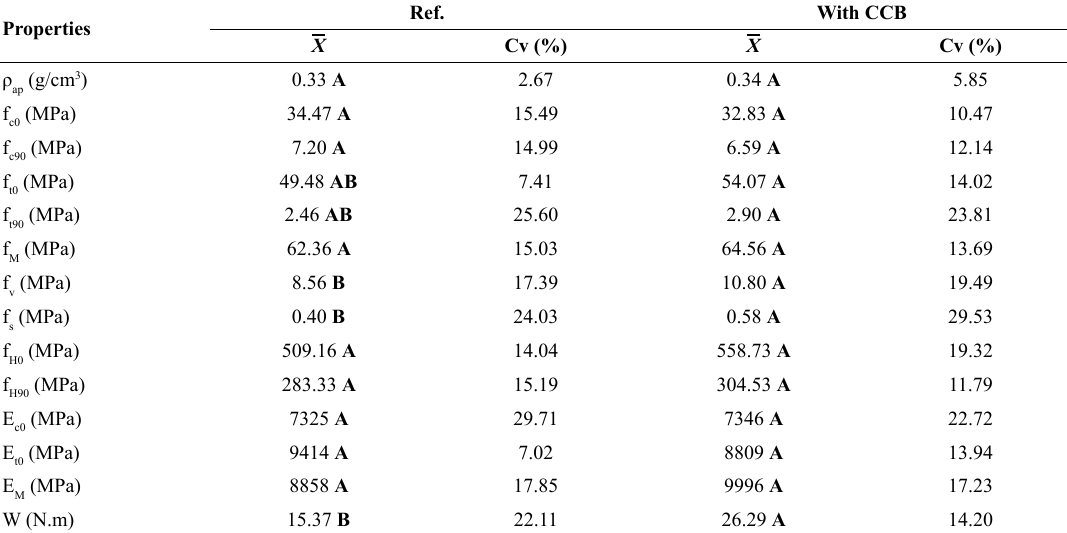
Table 3. Mean experimental values, coefficients of variation (Cv) and Tukey test results for the properties evaluated for S. amara